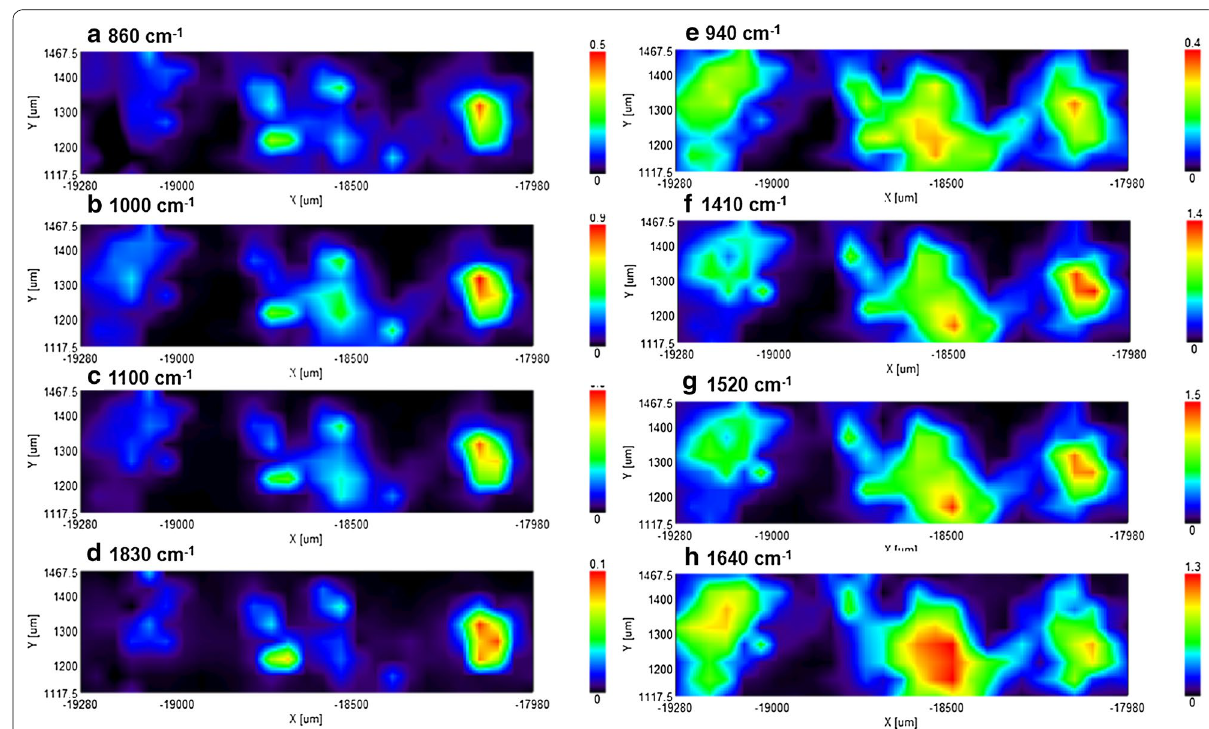
Fig. 10 IR peak intensity maps at a 860 cm − 1 with baseline between 780 and 1060 cm − 1 , b ~ 1000 cm − 1 with baseline between 780 and 1060 cm − 1 , c 1100 cm − 1 with baseline between 1060 and 1140 cm − 1 , d 1830 cm − 1 with baseline between 1780 and 1860 cm − 1 , e 940 cm − 1 with baseline between 780 and 1060 cm − 1 , f ~ 1410 cm − 1 with baseline between 1250 and 1750 cm − 1 , g ~ 1520 cm − 1 with baseline between 1250 and 1750 cm − 1 , and h ~ 1640 cm − 1 with baseline between 1250 and 1750 cm − 1 . IR imaging on Fig. 10 is corresponding to the region of interest in Fig.